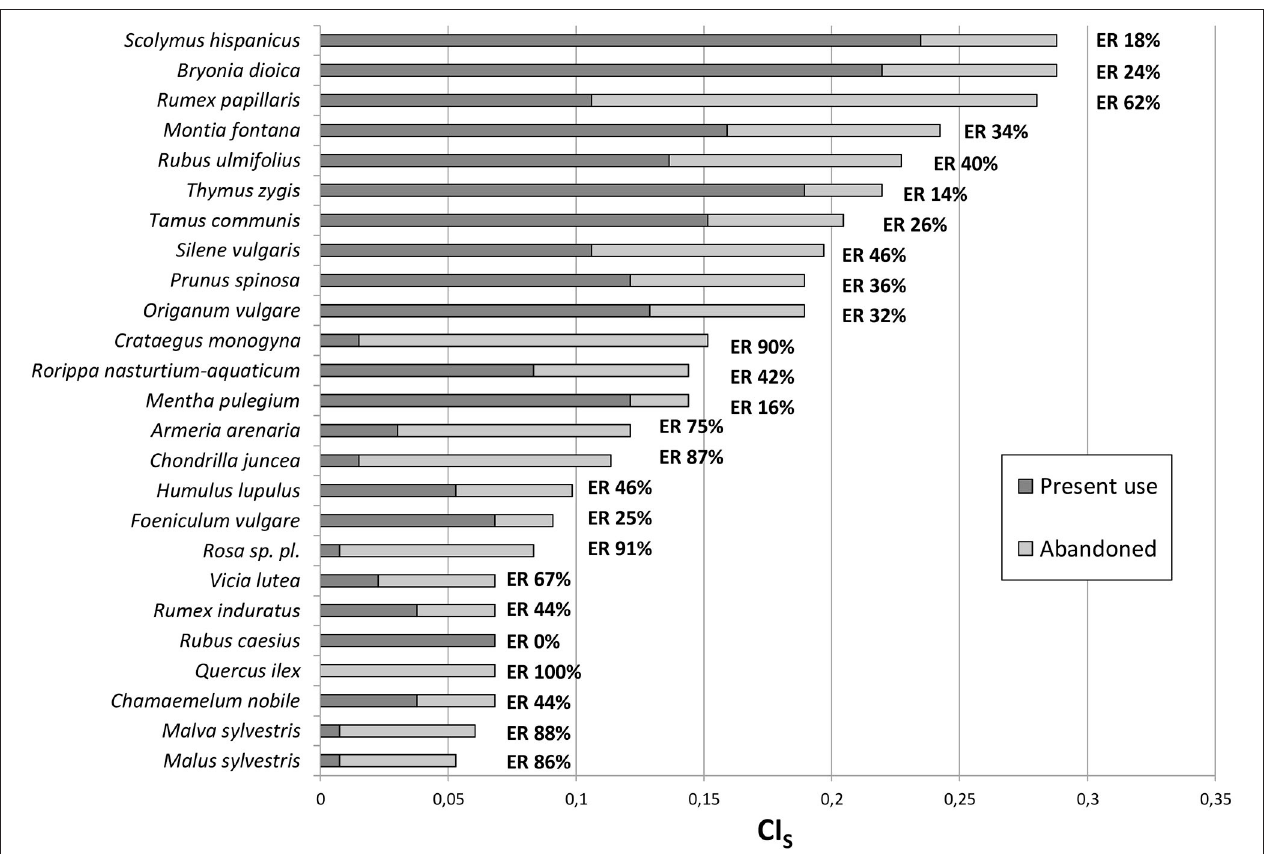
FIGURE 3 | Cultural importance index (CI) and erosion rate (ER) of the 25 wild food species with the highest CI in Sierra Norte de